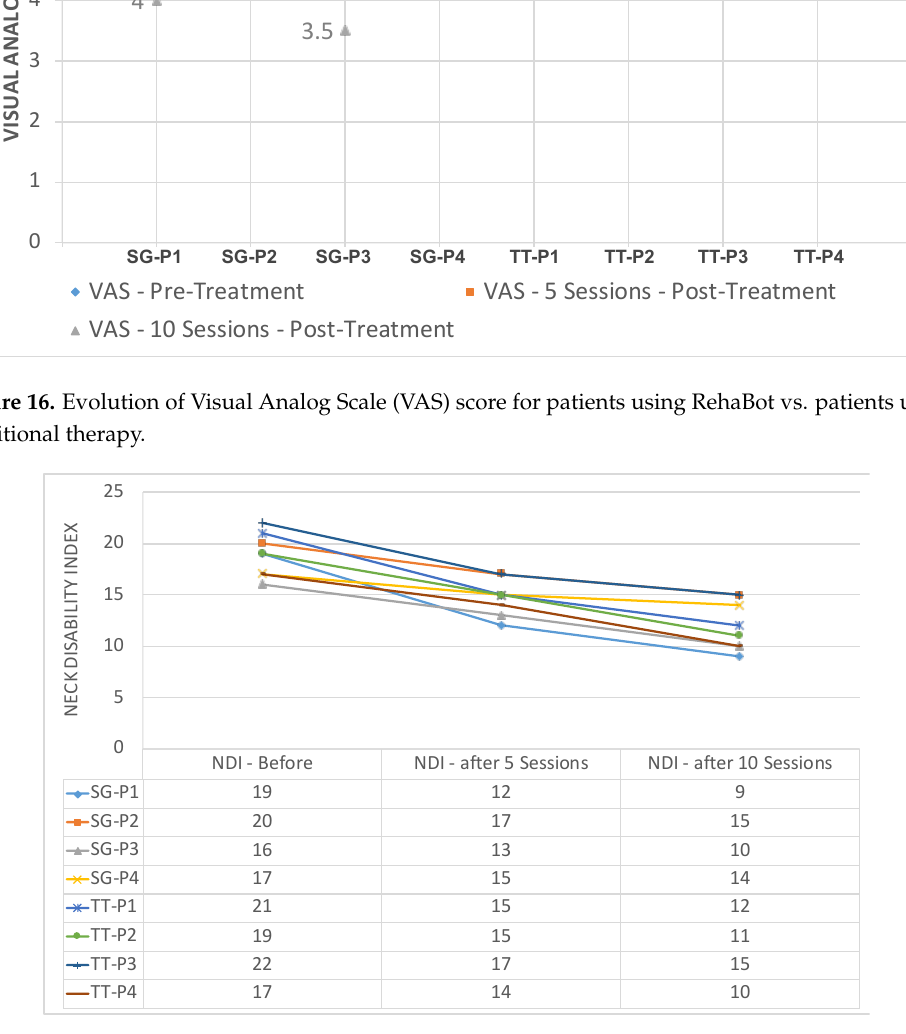
Figure 17. Neck Disability Index for patients using RehaBot (SG-P1 → SG-P4) vs. patients with traditional therapy (TT-P1 →